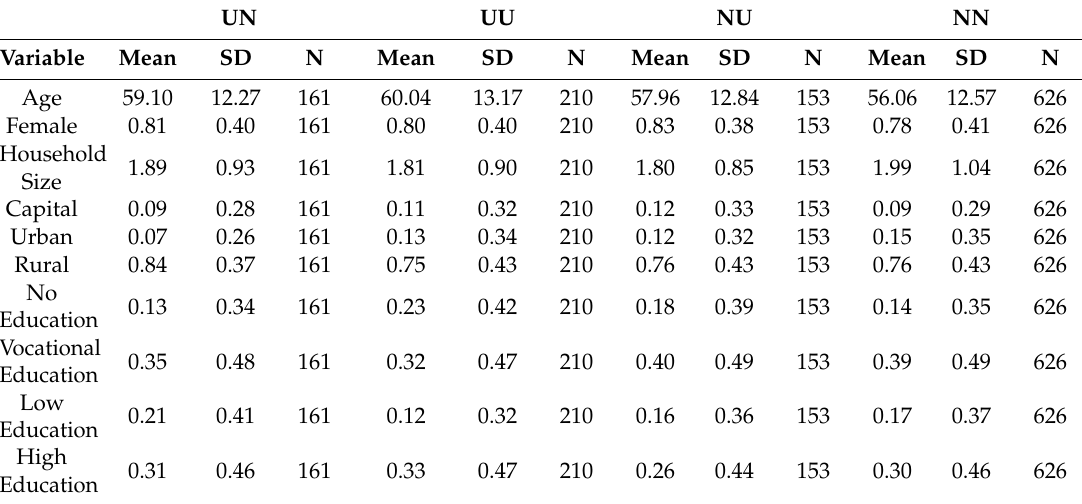
Table A2. Summary statistics for DoC subgroups in